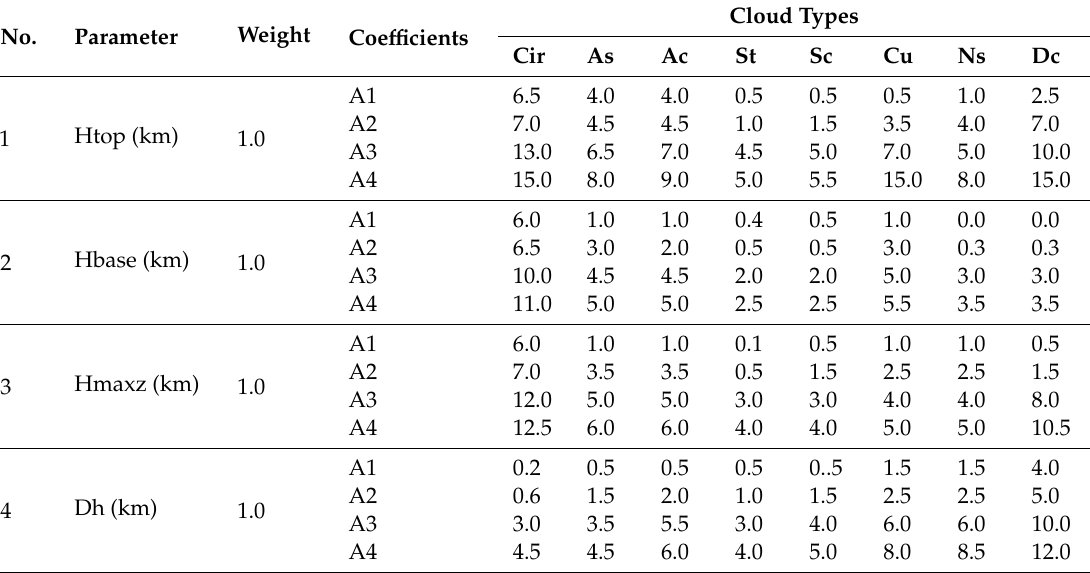
Table 3. A1, A2, A3, A4, and the weights for eight characteristic parameters and eight cloud types. No. Parameter Weight Coe ffi